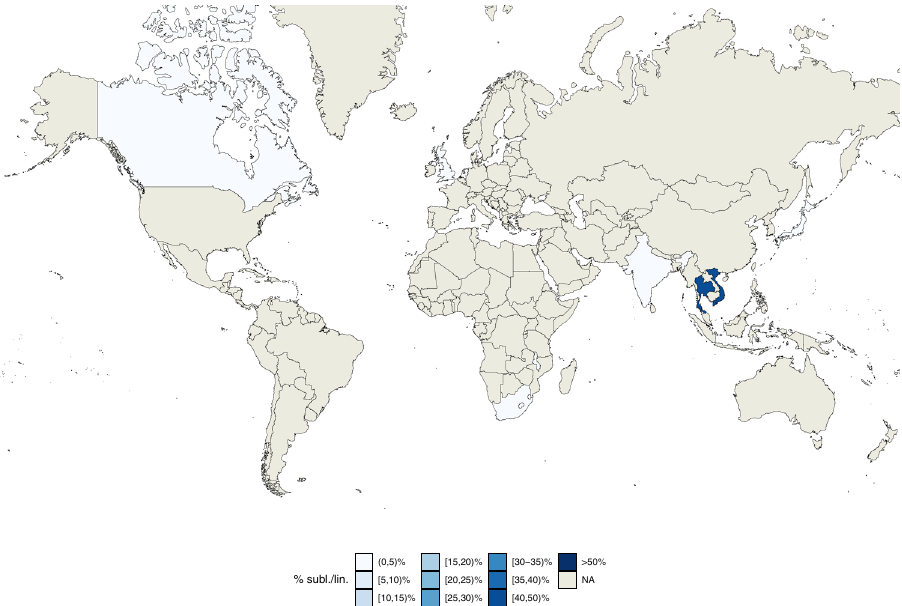
Fig. 7 Geographic distribution of internal sub-lineage 1.1.1.1. Colors represent the percentage of 1.1.1.1 strains isolated in a given country with respect to all lineage 1 strains isolated in such country. Source data are provided as a Source Data fi